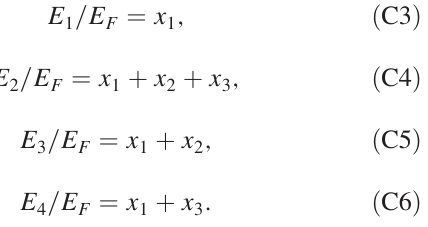
FIG. 6. Prepared degeneracy T=T rvoirs and the channel center versus local chemical potential μ The gray dotted lines locate the normal-to-superfluid transition inside the locally homogeneous channel at T μ 0 . 428 μ K, respectively. The violet horizontal line indicates loc ¼ the critical degeneracy in the reservoirs. Error bars represent the standard deviation over five repetitions prepared under the same